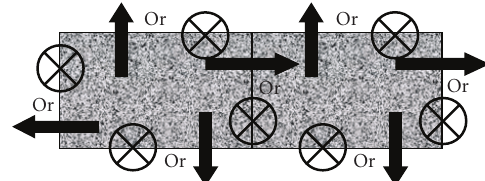
Figure 5: Schematic diagram of the upwind-downwind grids.